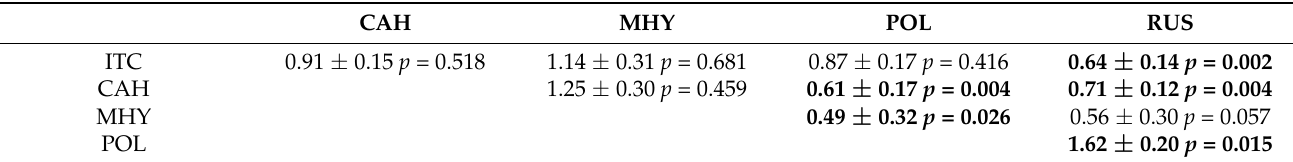
Table 1. Hazard ratio ( ± S.E.) for worker survival of IAPV inoculation for the stock on the top of each column relative to the stock on the left of each row. Hazard ratio refers to the ratio of probability of death, thus values above 1 indicate a higher probability of death in workers of the stock indicated above columns compared to the stock on the left. Significant differences based on uncorrected significant thresholds are typed in bold-face.